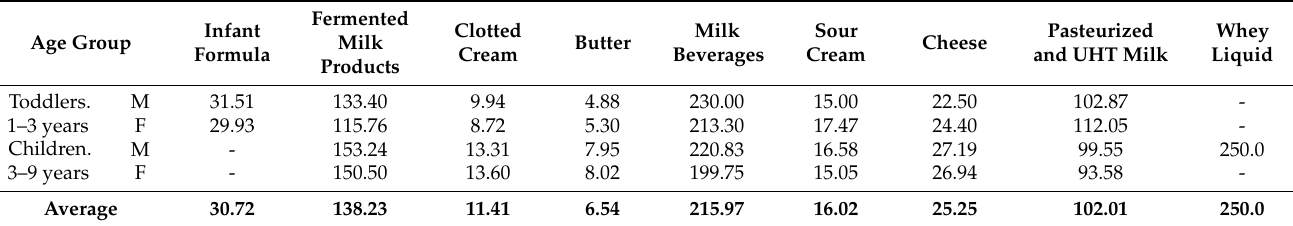
Table 3. The average intake of food groups by child population (g/day)